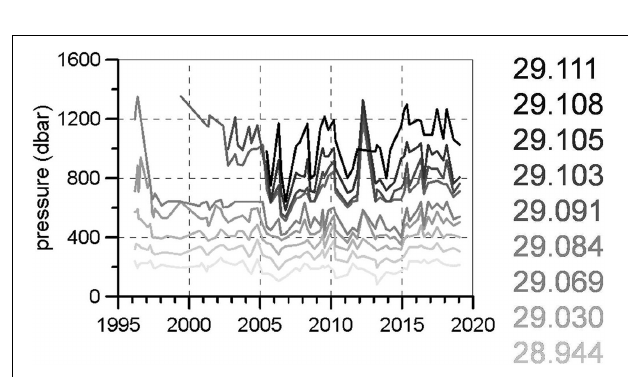
FIGURE 11 | Evolution of the depth (pressure level) of certain selected isopycnals representing different water masses from WIW to deep waters.